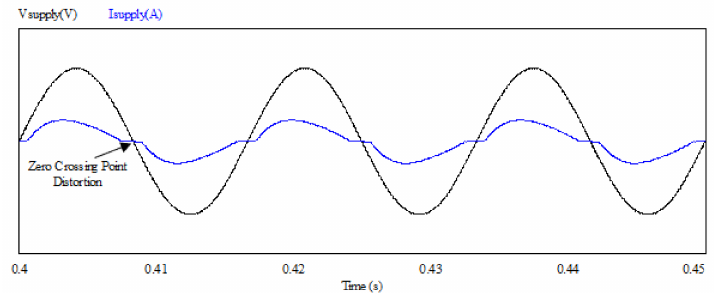
Figure 2. Supply voltage-current waveforms for PFC-boost converter with conventional PI current